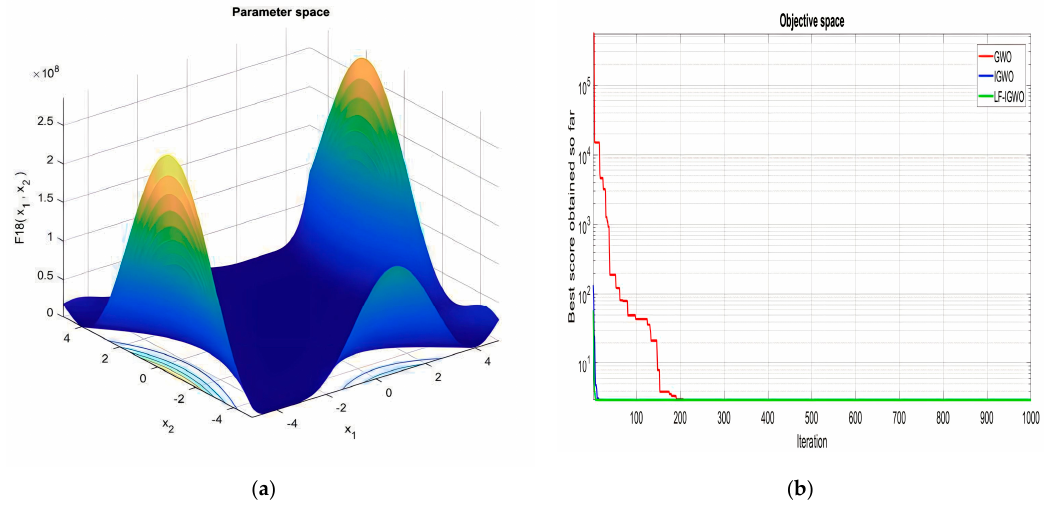
Figure 20. ( a ) Search space for fixed dimensional function F18 ( b ) Comparison of convergence curve for F18.